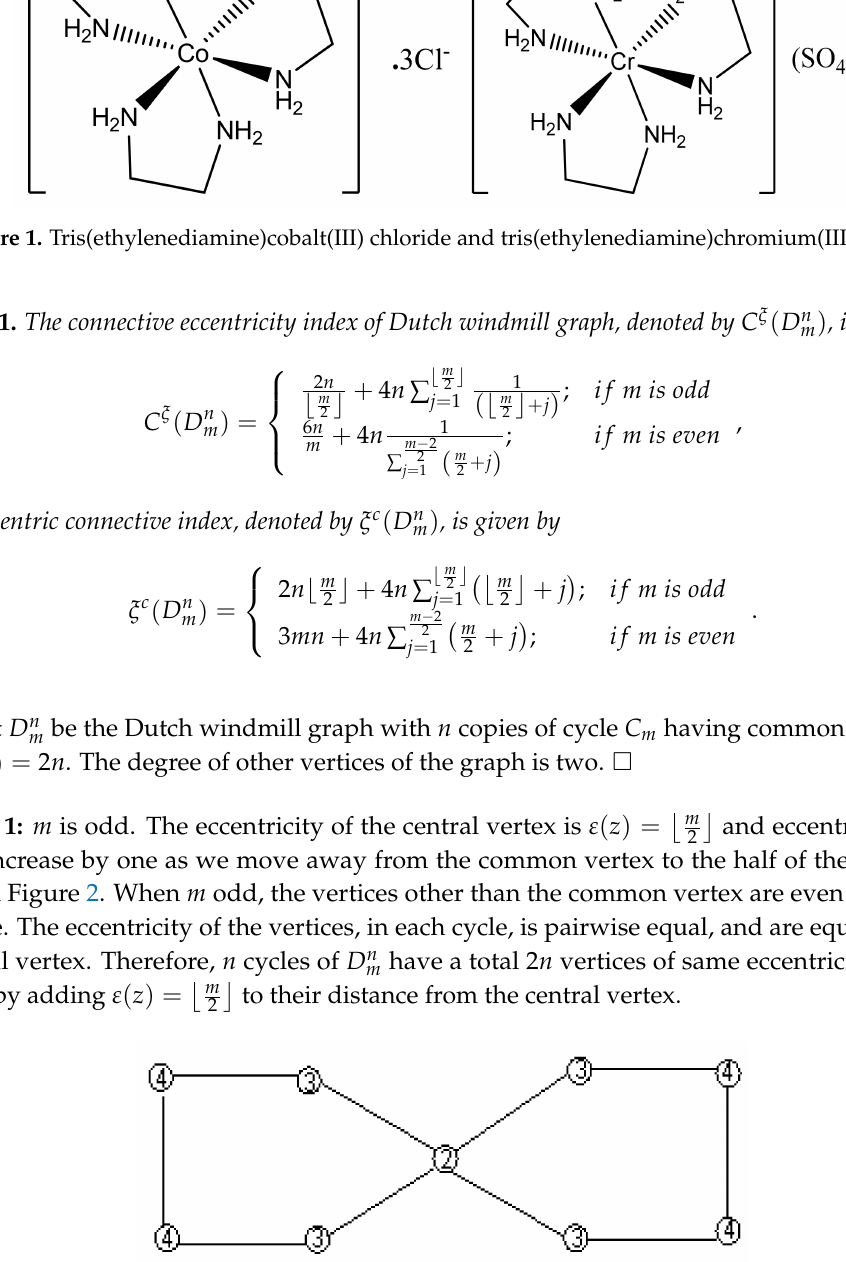
Figure 2. Dutch windmill graph D 2